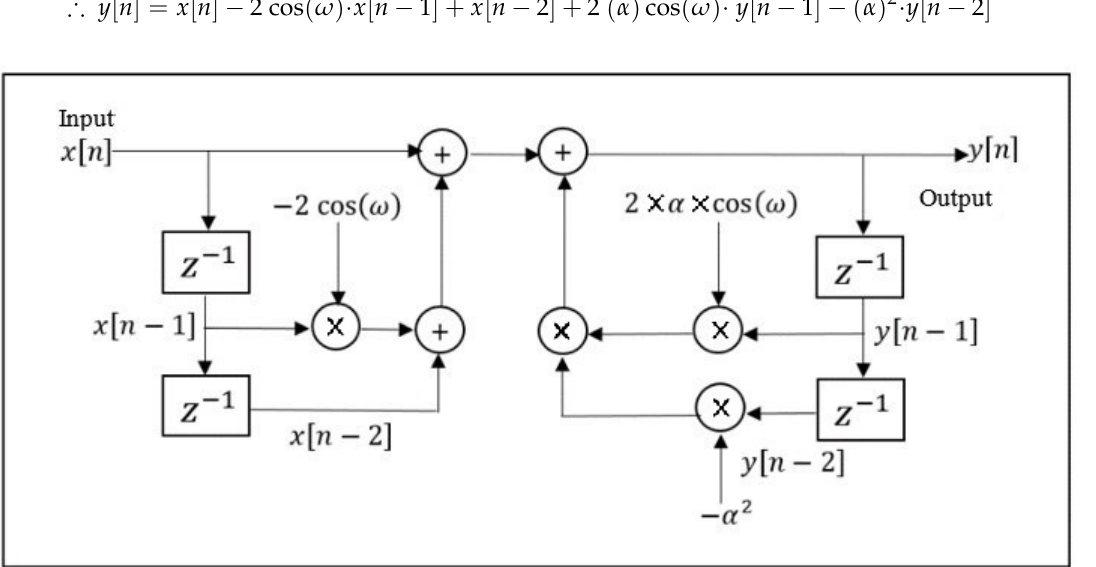
Figure 7. Data flow of the second-order IIR notch filter.